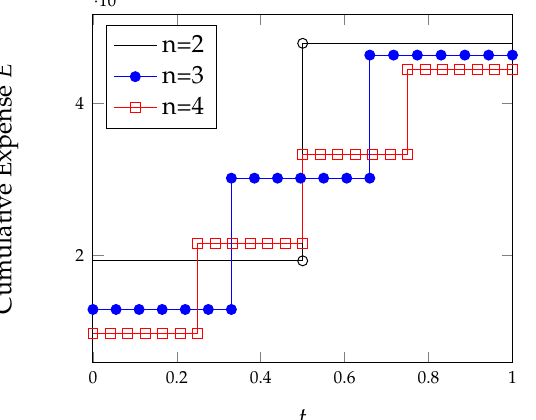
Figure 2. Optimal cumulative investment under full liability and GL1 model.